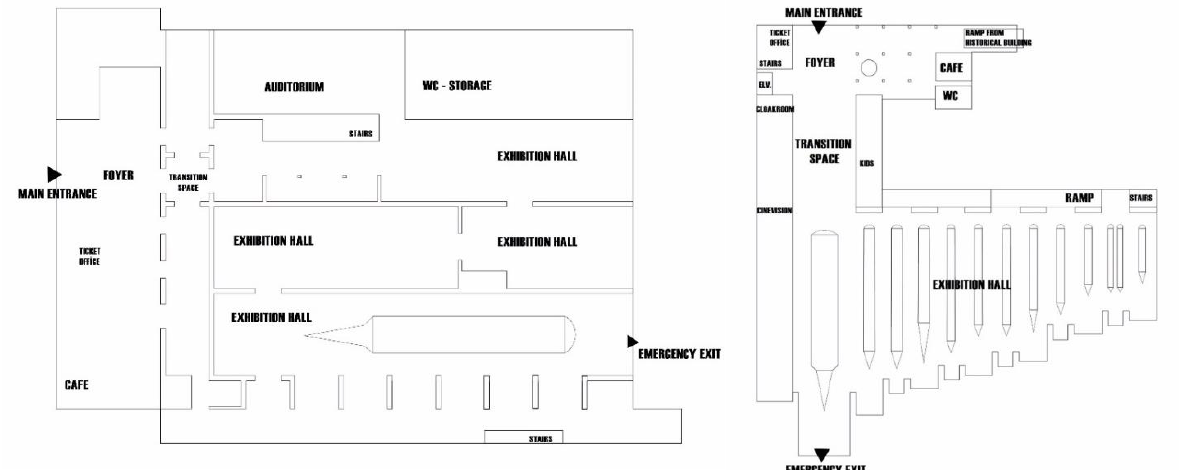
Figure 8 Ground floor plan of Genova Galata Museo Del Mare (left), Ground floor plan of İstanbul Deniz Müzesi